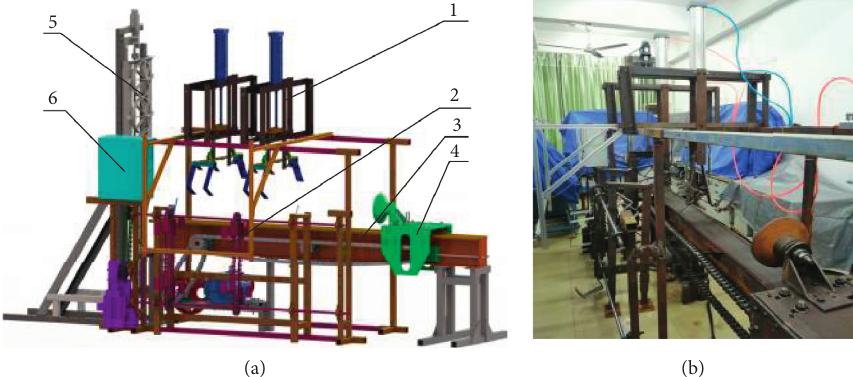
Figure 3: (a) The virtual model and (b) the image of developed bamboo-splitting